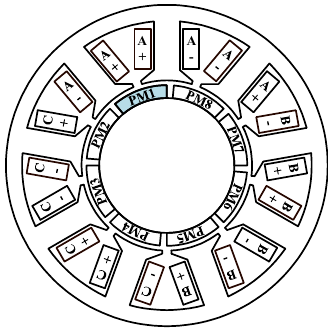
Figure 1. Structure of 9 − slot and 8 − pole PMSM.